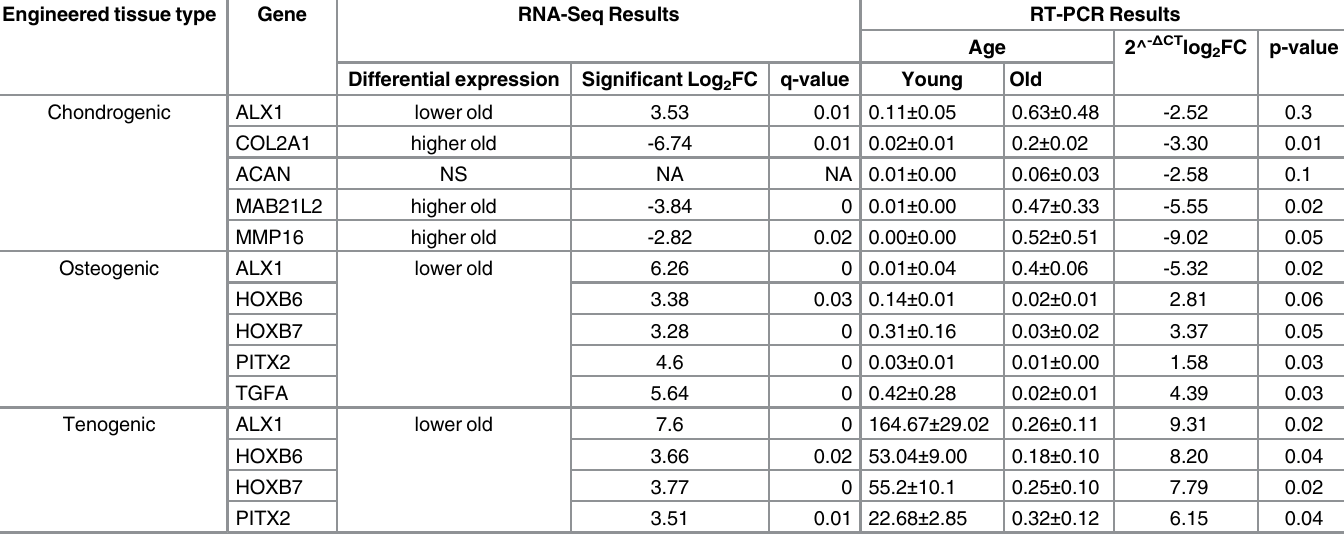
injury [47]. Our previous work in bone-marrow-derived MSCs using a systems biology approach demonstrated an altered phenotype in MSC ageing at a number of levels, implicating roles for inflammageing and mitochondrial ageing [48]. The changes identified represented novel insights into the ageing process, with implications for stem cell therapies in older patients. Table 5. Real-time polymerase chain reaction analysis of selected genes for each engineered tissue type revealed good correlation with RNA-Seq results. Engineered tissue type Gene